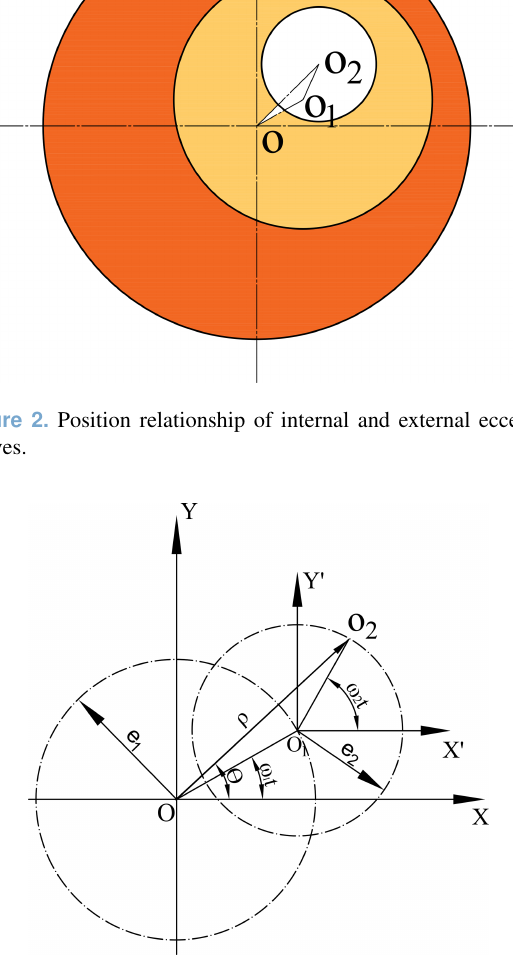
Figure 3. Eccentricity vectors of internal and external eccentric